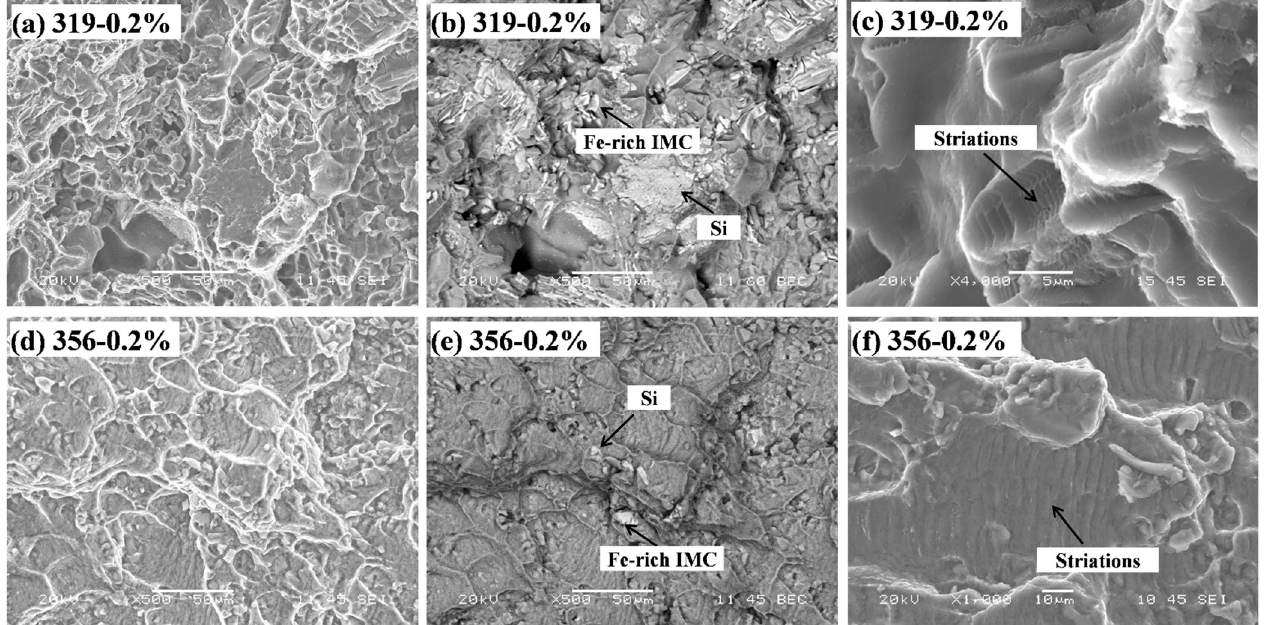
Figure 6. Fractography of fractured specimens after 0.2% TMF test: ( a – c ) 319 alloy; ( d , e ) 356 alloy; ( a , c , d , f ) SEM secondary electron images; ( b , e ) SEM backscatter images.